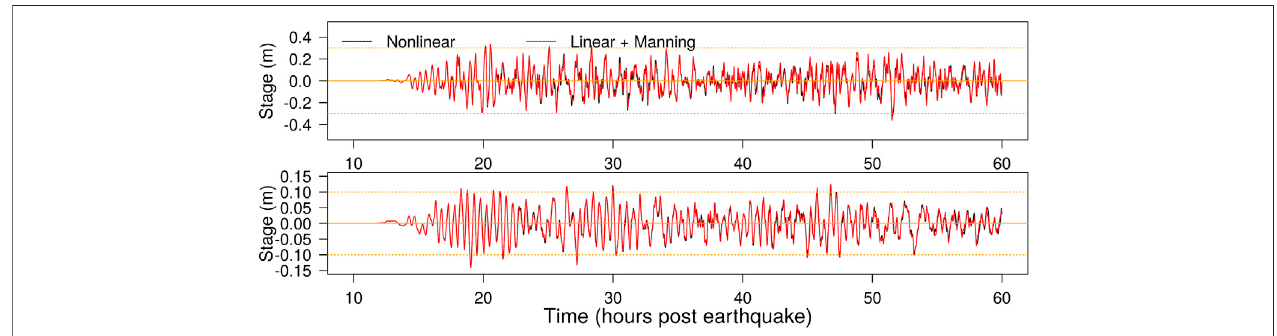
FIGURE 5 | Comparison of nearshore gauge results in two models which use different solvers on the global grid; one solves the full NSWE, the other solves the LSWE with a nonlinear Manning-friction term. In both cases the NSWE are solved on re fi ned grids. The site locations and scenario details are the same as in Figure 4